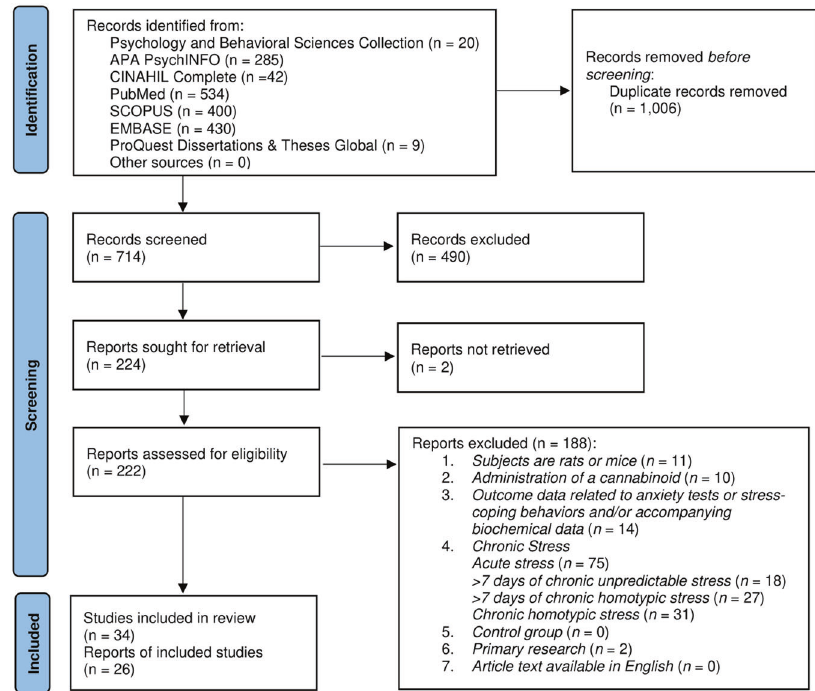
Fig. 1 PRISMA fl owchart [67]. Flowchart of the literature search and selection